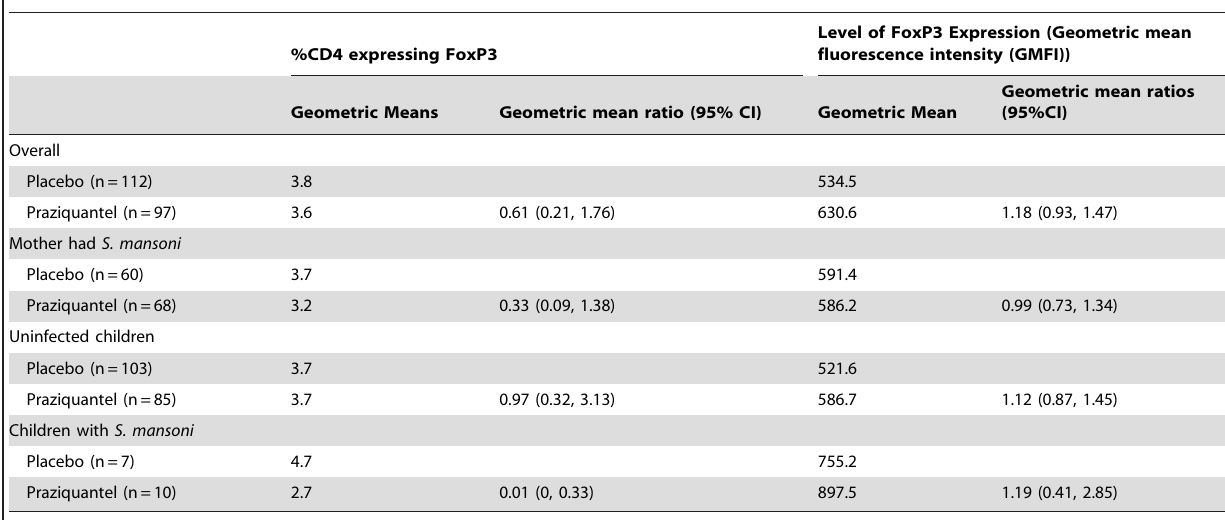
Table 4. Effect of praziquantel treatment during pregnancy on regulatory T cells expression among offspring at age five years.